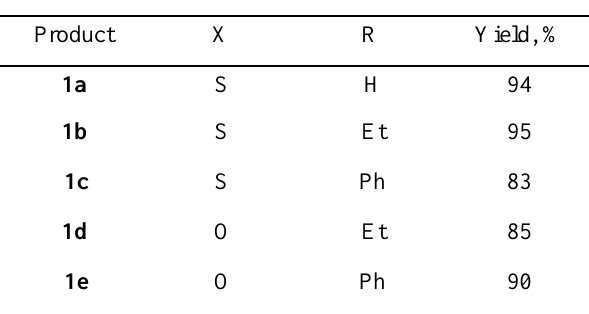
Table 1 . Synthesis of a -tosyl substituted thioureas 1a-c and ureas 1d,e